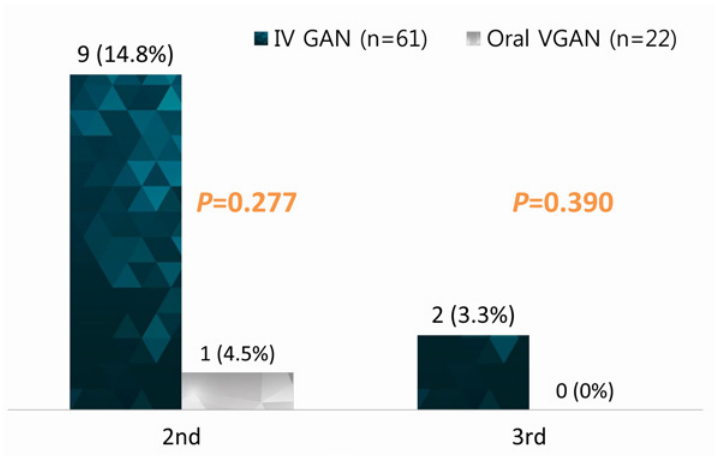
Fig 1. Rates of CMV reinfection after preemptive treatments. Relapsed secondary CMV infection rates in the intravenous GCV and in the oral VGCV groups were 14.8% and